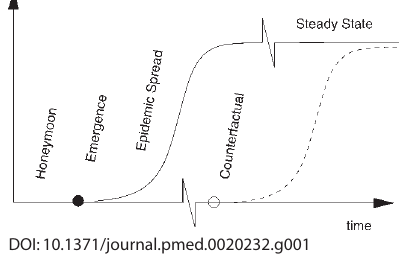
Figure 1. The Emergence and Spread of Antibiotic Resistance in Bacteria with High Horizontal Transmission